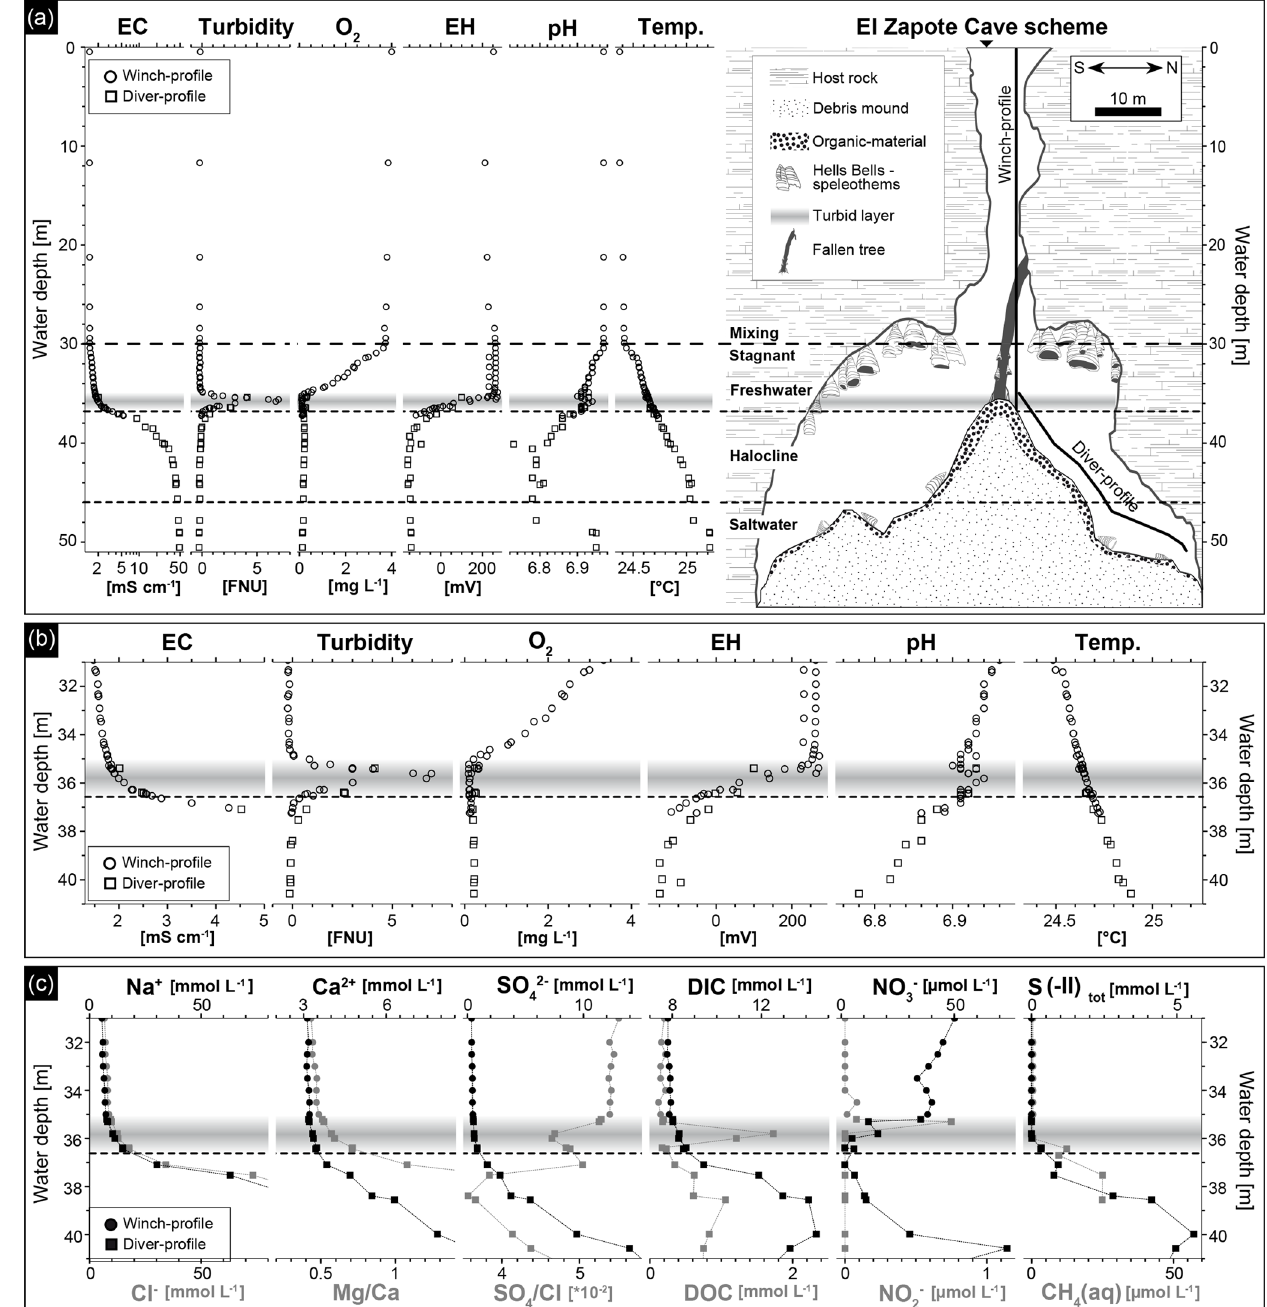
Figure 3. Hydrogeochemistry of the water column of El Zapote cenote. The horizontal gray band indicates the depth position of the turbid layer, while the dashed line indicates the top of the halocline at 36.6m water depth. (a) Water in situ parameters versus water depth (left) in relation to the El Zapote cenote cross section (right). In situ parameters and samples were taken along a winch profile and a diver profile as shown in the cenote cross section. Note the logarithmic scale of the electrical conductivity (EC). (b) Close-up of the water in situ parameters at 31–41m water depth. Note that the scale of EC is non-logarithmic and is only shown for the range between 1 and 5mScm − 1 , in order to point out the increase in salinity at the beginning of the halocline. (c) Water chemical parameters determined in the water column between 31 and 41m water depth. Na + and Cl − concentrations are only shown in the range of 0–80mmolL − 1 to highlight the concentration pattern above and within the